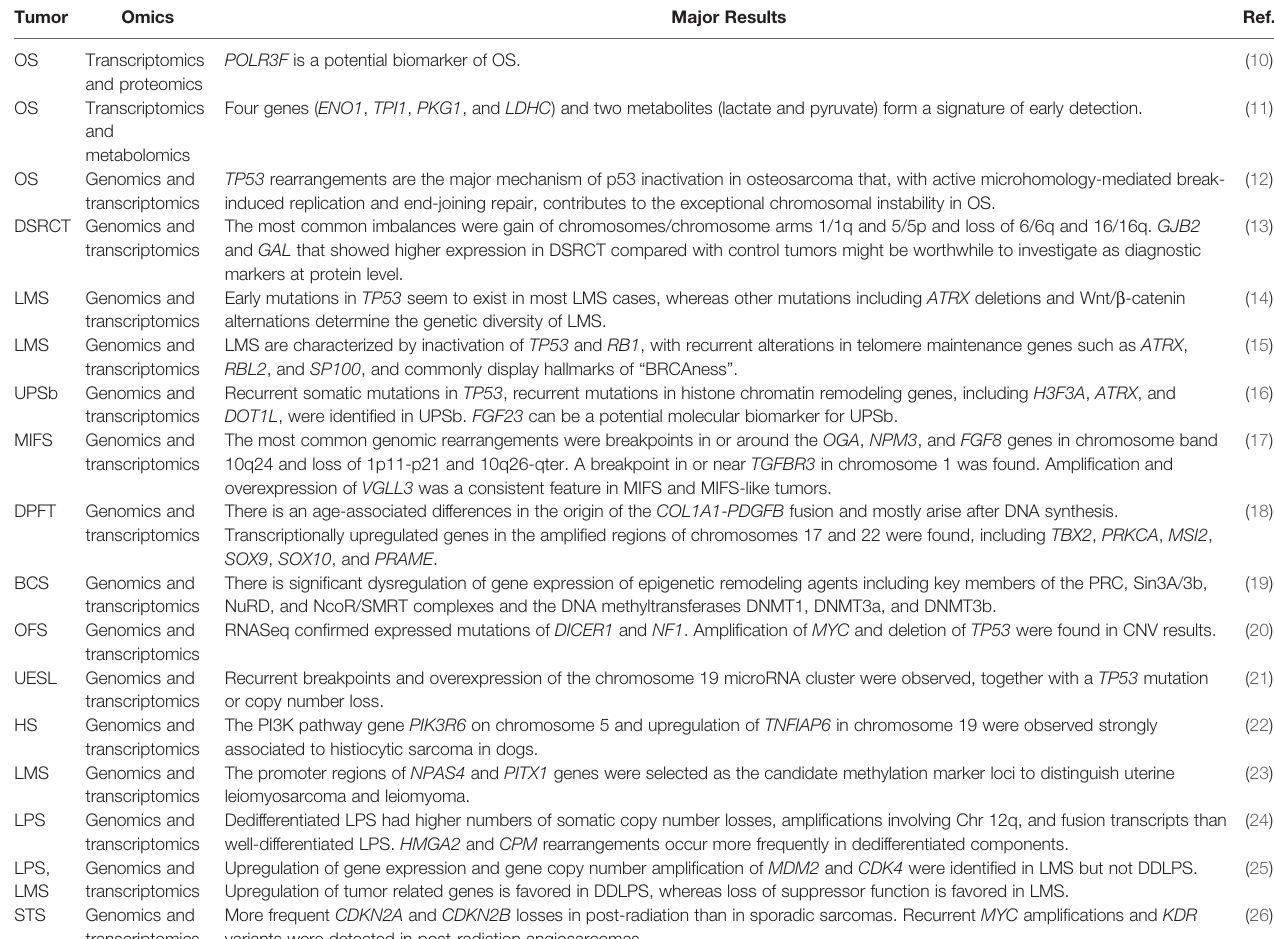
TABLE 1 | Major results, sarcoma subtypes, and omics technologies of the multi-omics studies described in this review.